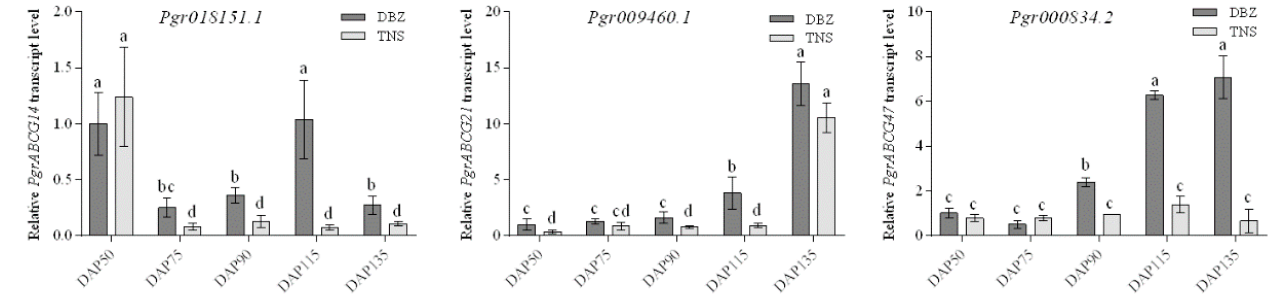
Figure 3. Relative expression levels of the candidate PgrABCG genes in the inner seed coats of hard- seeded pomegranate ‘Dabenzi’ and soft-seeded pomegranate ‘Tunisia’ at five developmental stages. “DBZ” = ‘Dabenzi;’ “TNS” = ‘Tunisia;’ “DAP” = days after pollination. Error bars indicate standard deviation (n = 3). Different letters indicate a significant difference at p < 0.05 using Tukey’s